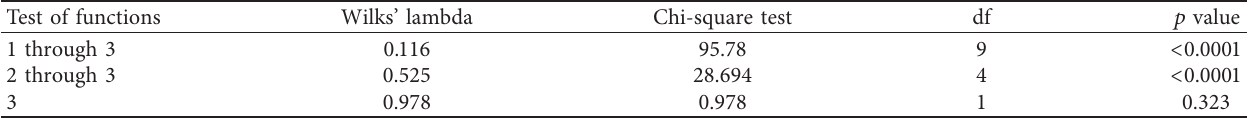
Table 2: Wilks’ lambda values.